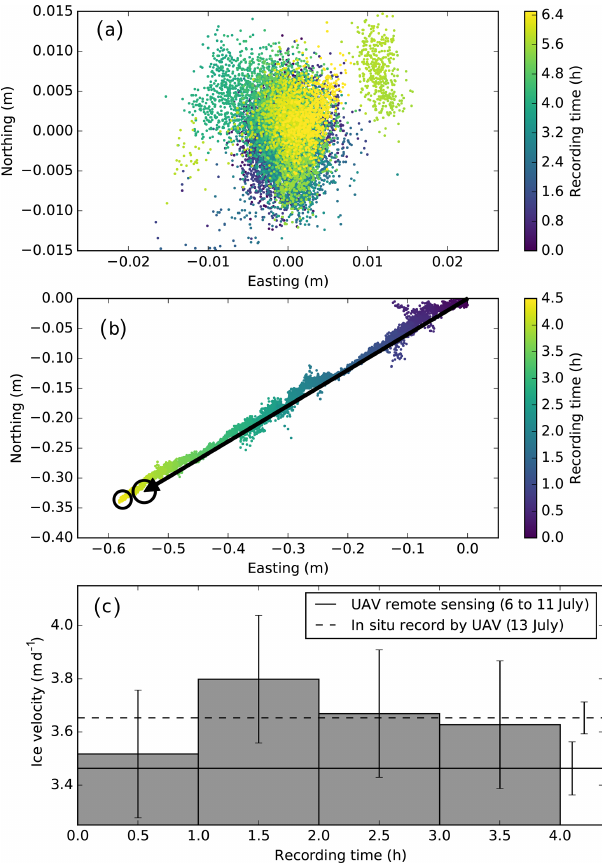
Figure 3. (a) Processed horizontal positions during the static test of our differential GNSS receiver relative to the mean position. (b) Processed horizontal positions of the quadcopter UAV while measuring the ice flow at Eqip Sermia Glacier relative to the land- ing position on 13 July. The arrow shows the ice displacement vec- tor estimated by SfM-MVS photogrammetry and template matching between 6 and 11 July, but rescaled over the recording time for com- parison purposes. The circles indicate the intervals of confidence from both results. (c) Velocity of ice at the recording site every hour determined from 1h window average positions. The continuous and dashed straight lines indicate the average ice flow motion over the entire recording time and the one inferred by template matching and SfM-MVS photogrammetry from 6 to 11 July,